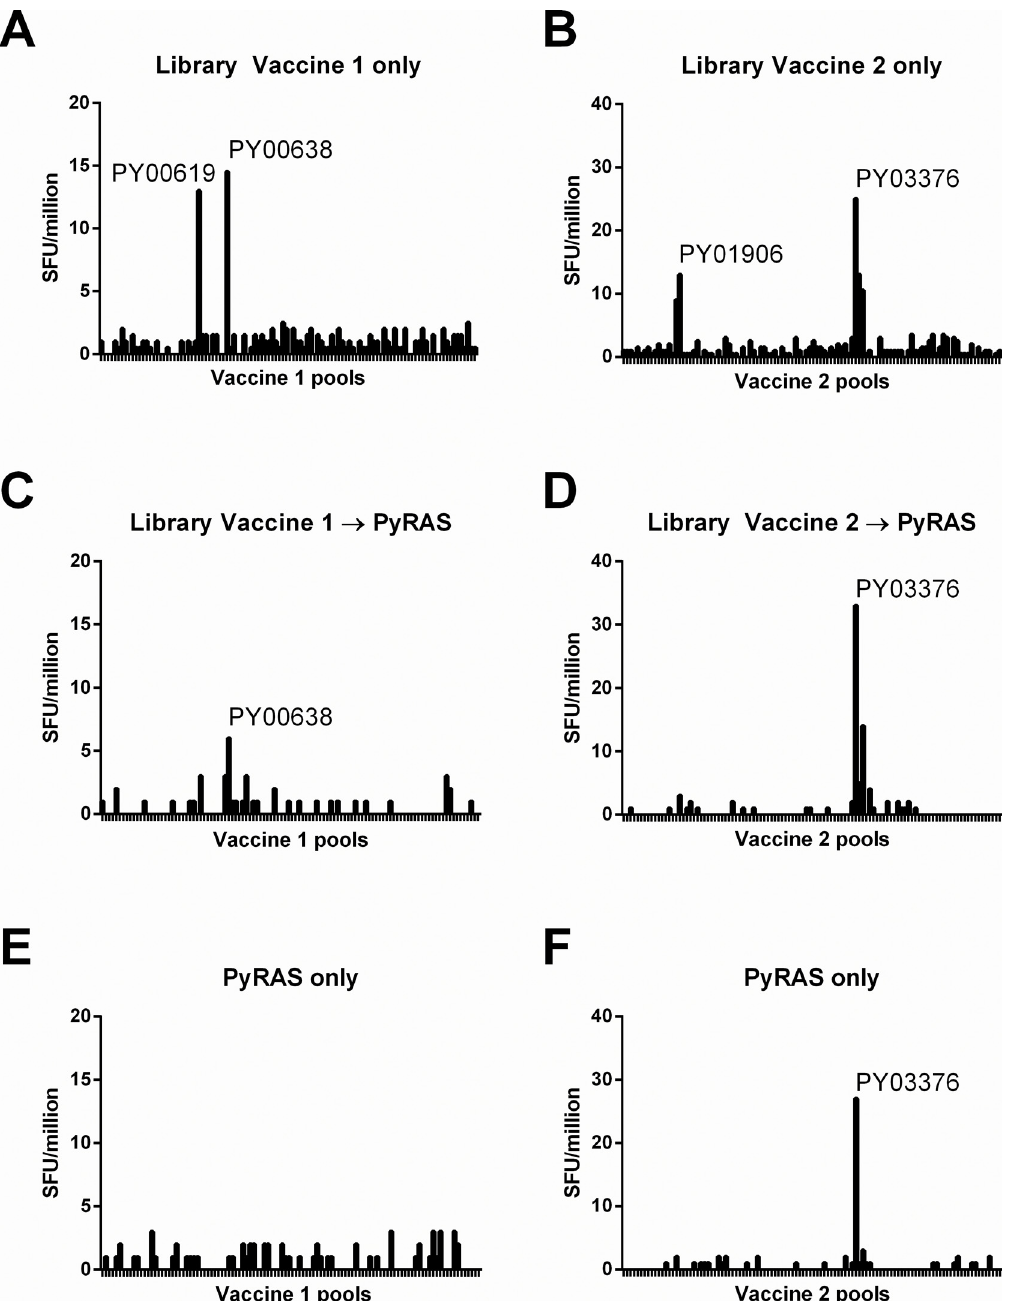
Fig 1. ELISPOT IFN γ responses in mice immunized with minigene library vaccines alone (A-B), library vaccines followed by sporozoites (C-D) or sporozoites alone (E-F) identify novel responses. ELISPOT results for Vaccine 1 (A,C,E) and Vaccine 2 (B,D,F), as indicated. Responses to Library vaccination alone (A-B), Library vaccine plus Sporozoites (C-D) or Sporozoites only (E-F). Minigene pools are indicated along the x-axis (Vaccine 1 = 103 pools; Vaccine 2 = 105 pools) with the y-axis indicating SFU/million